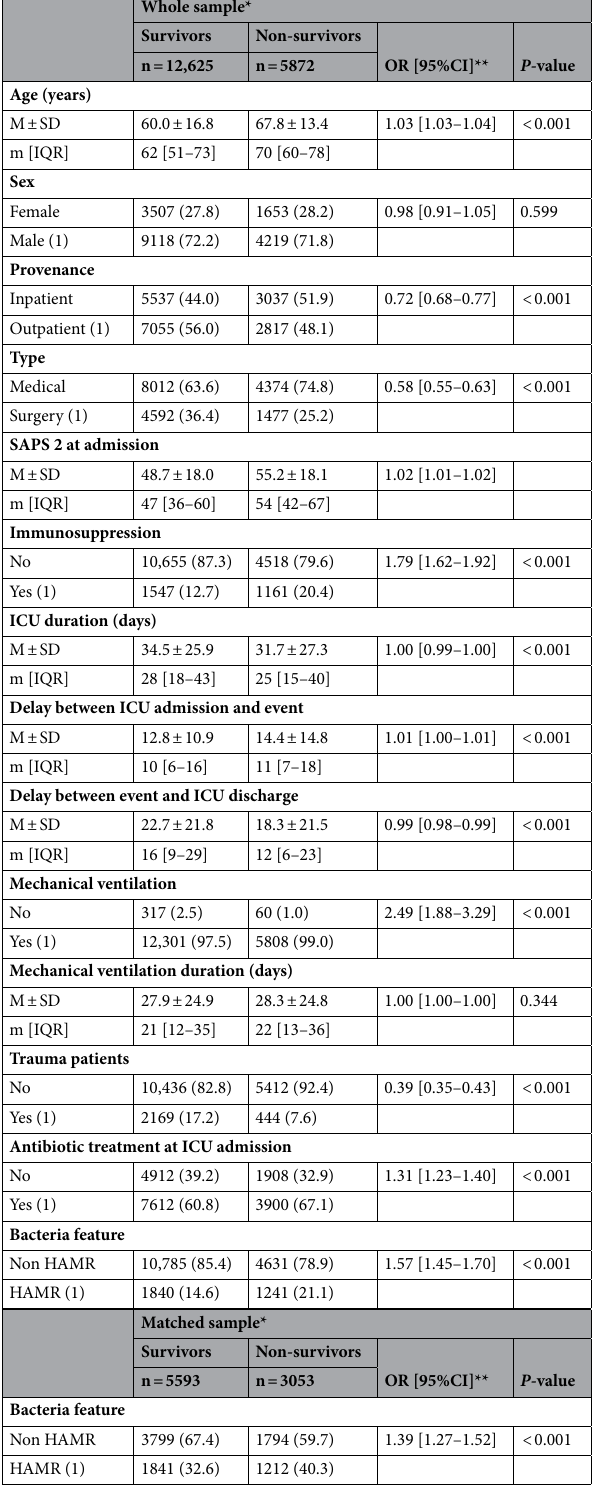
Table 3. Factors associated with ICU mortality on the whole sample and the matched sample (univariate analysis). ICU intensive care unit, HAMR highly antimicrobial resistant SAPS2 simplified acute physiology score. M ± SD: mean ± SD; m [IQR]: median [interquartile range]; OR [95%CI]: odd ratio [95% confidence interval]. *with vital status not missing; **OR is provided for the modality